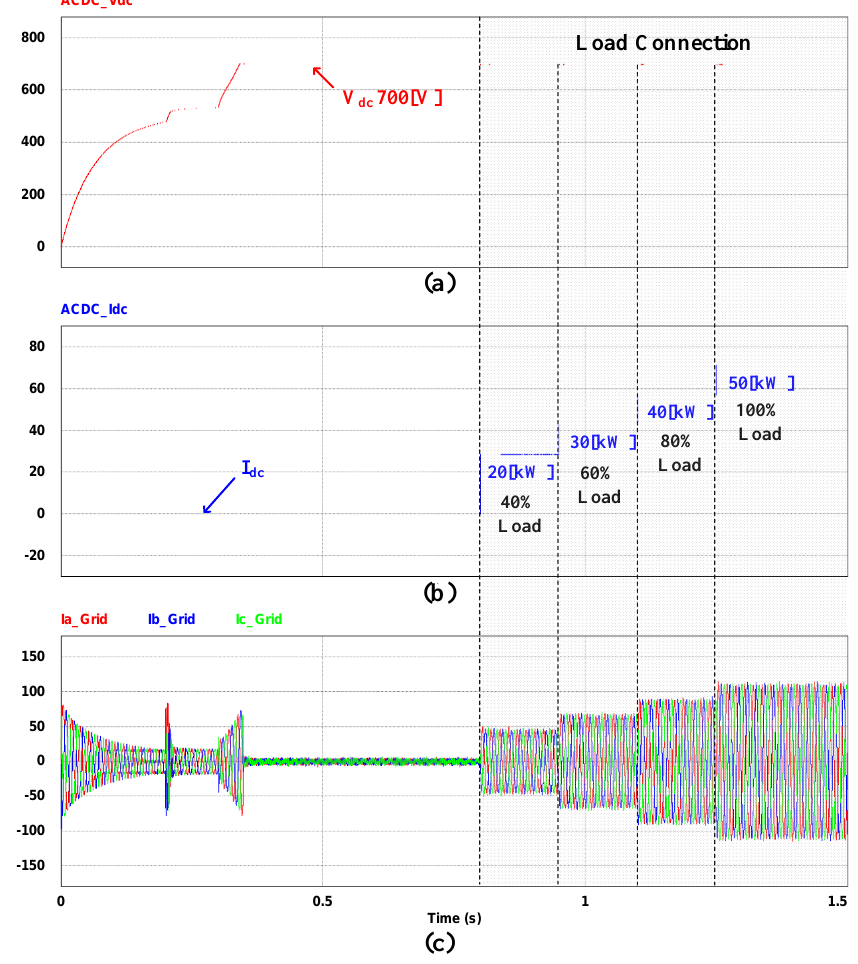
Figure 16. Input and output waveforms of DC distribution system ( a ) the dc-link voltage; ( b ) the current of the DC load; and, ( c ) the current of the grid.